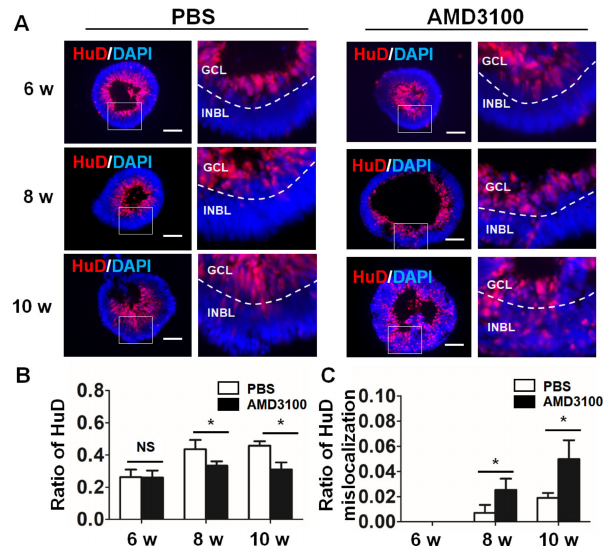
Figure 4. CXCR4 blockade impairs retinal progenitor cells differentiation in retinal organoids. ( A ) Double-staining for MCM2 (progenitor cell marker) and TUJ1 (neuron cell marker) in the PBS and AMD3100 groups at various developmental stages of retinal organoids. ( B ) The relative ratio of MCM2-positive cells to all cells (nuclei were stained with DAPI) was not significantly different between the two groups ( p > 0.1, n = 15). ( C ) The relative ratio of TUJ-positive cells to all cells (nuclei were stained with DAPI) was significantly decreased in the AMD3100 group (* p < 0.05, NS: Not Significant, p > 0.05, n = 15). Scale bars: 100 µ m.